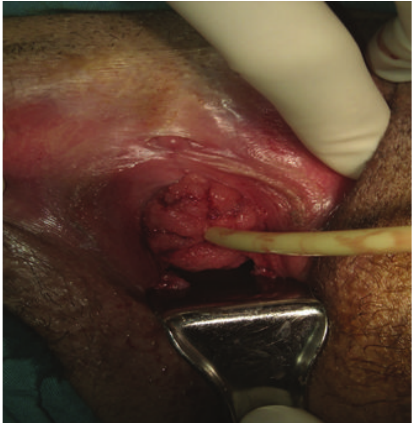
Figure 1: GCA was detected that completely surrounded the external urethral orifice.